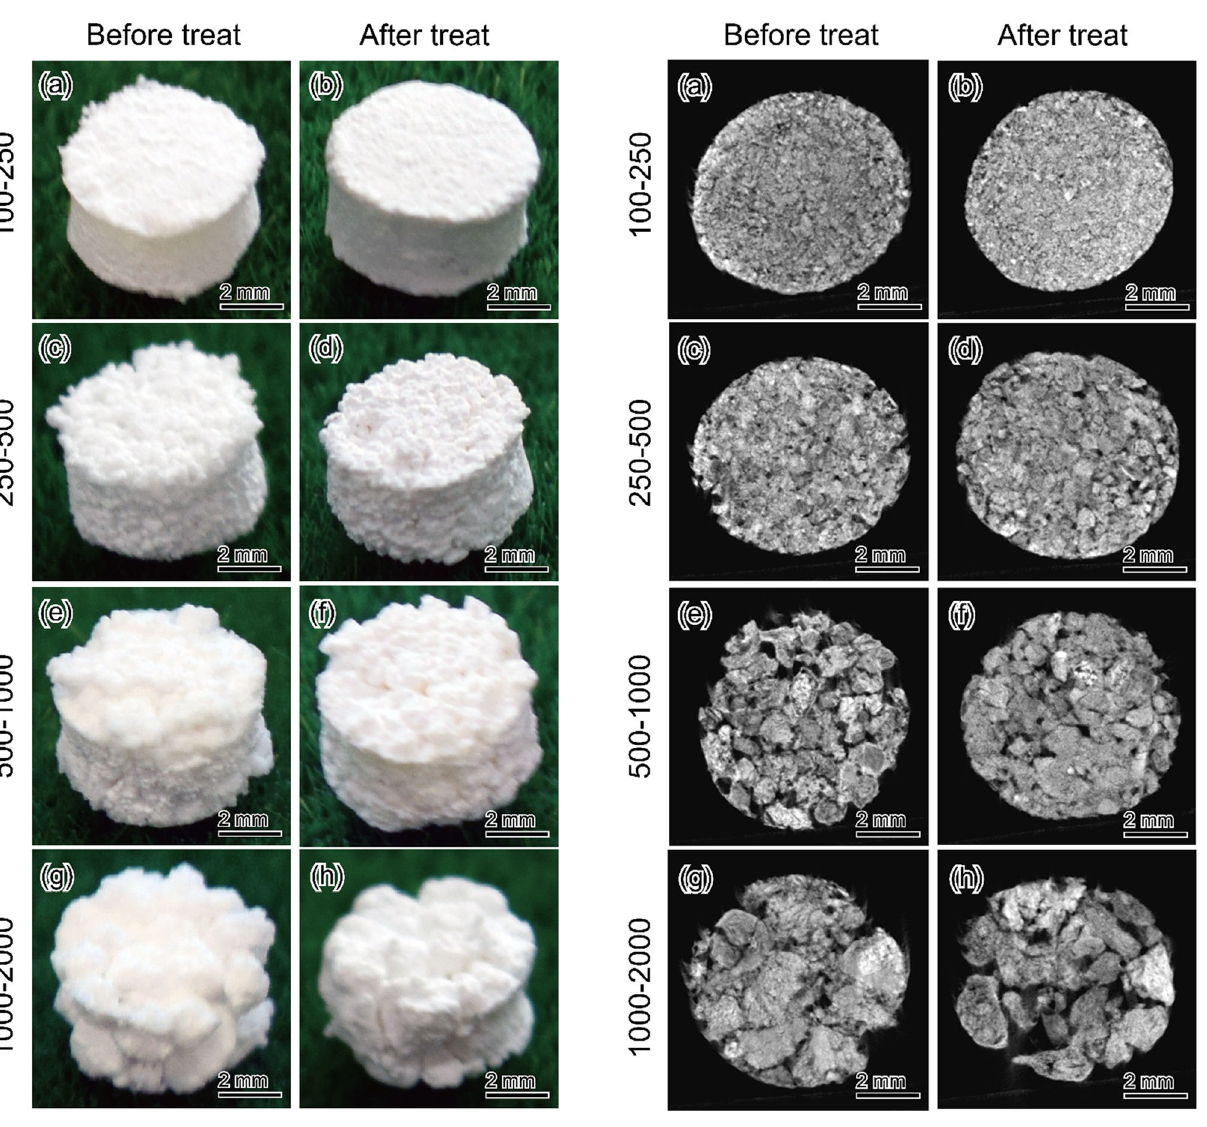
Fig. 2 Representative cross-sectional microCT images of acidic cal- cium phosphate foams before ( a – d ) and after ( e – h )